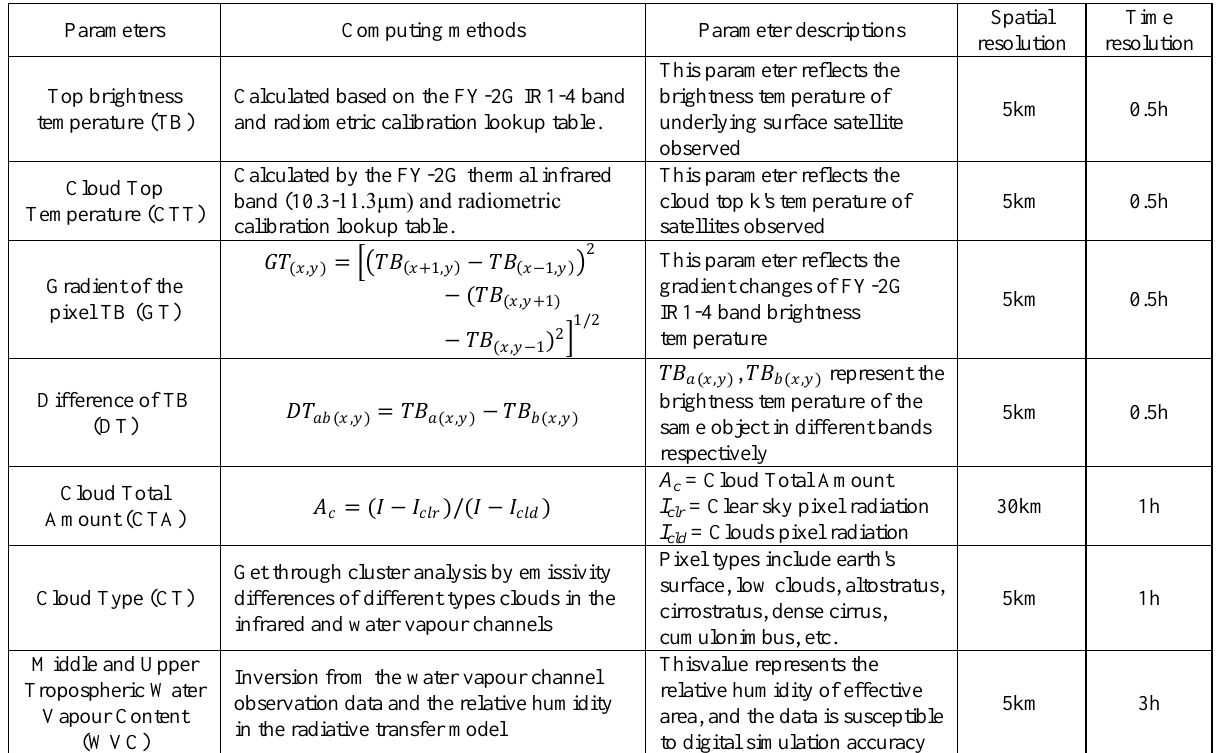
Table 1. FY-2G satellite inversion parameters